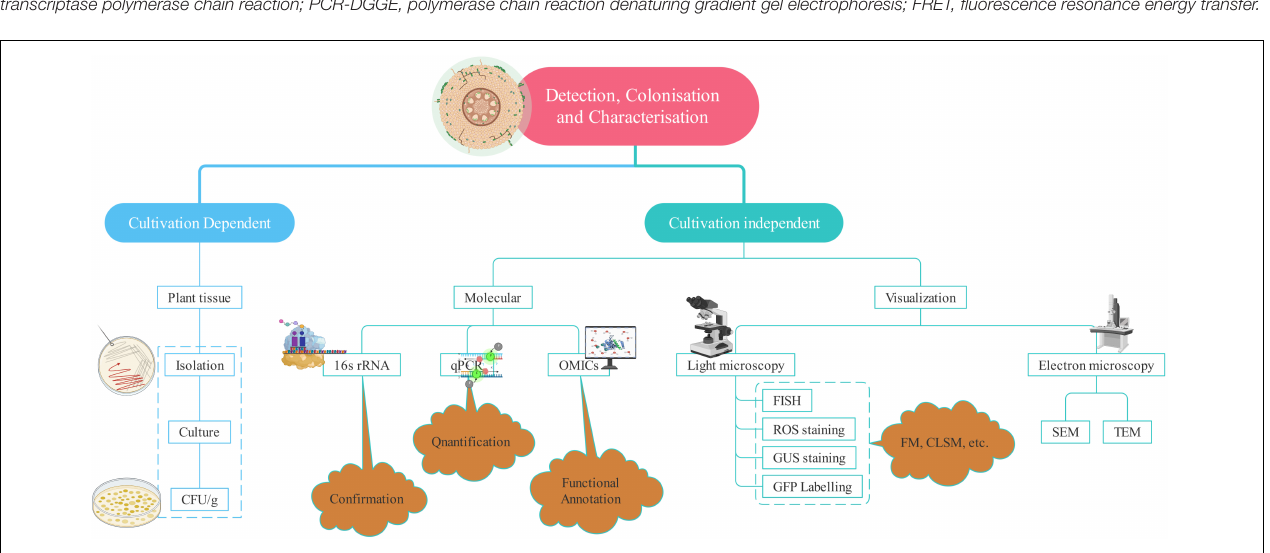
endophytes (Pimentel Esposito-Polesi et al., 2017).